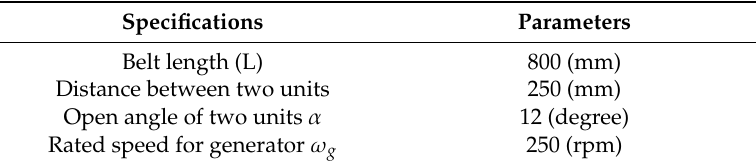
Table 2. Parameter of